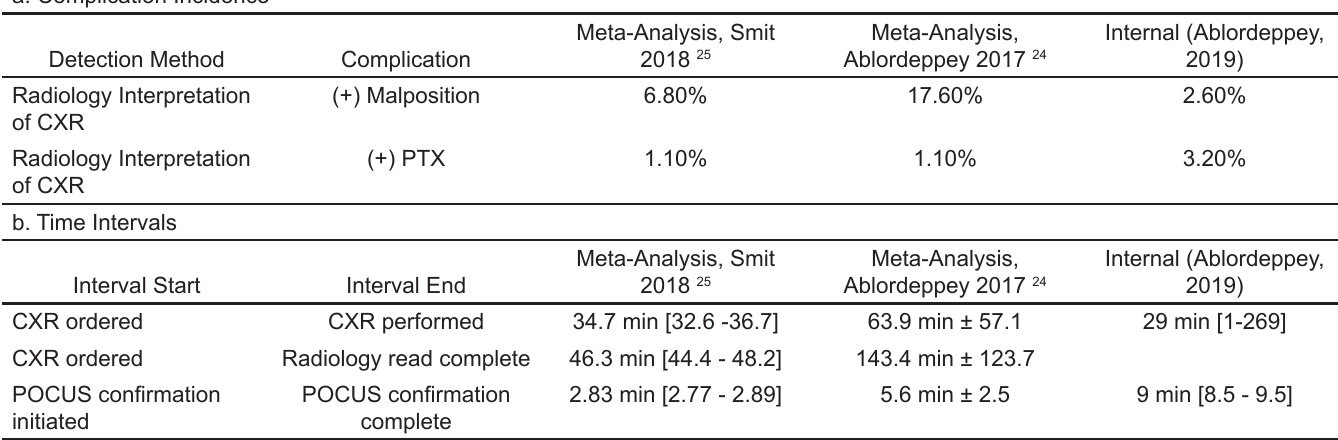
Table 2. Complication probability (2a) and time (2b) variables of chest radiograph and point-of-care ultrasound use for catheter confirmation